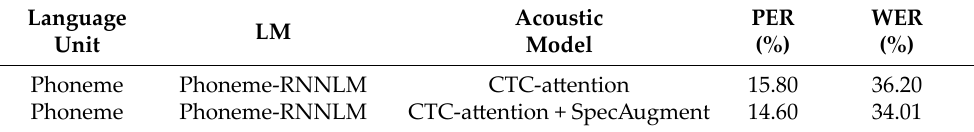
Table 4. Phoneme‑based end‑to‑end modeling with phoneme‑RNNLM decoding